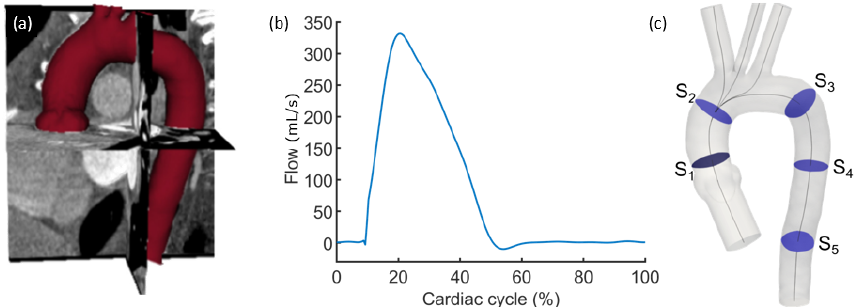
Figure 4. ( a ) Patient-specific aorta model segmentation from the CT dataset; ( b ) Flow boundary conditions applied to the inlet of the aortic model as extracted from patient phase contrast MRI data; ( c ) Visualization of the five cross-sections defined for the patient-specific model based on center line perpendicularity.